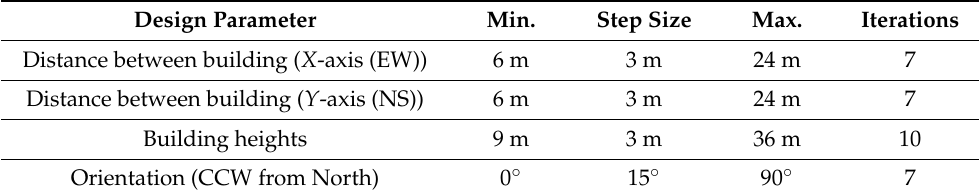
Table 1. Minimum, maximum and step size of each dynamic parameter simulated. Design Parameter Min. Step Size Max. Iterations Distance between building ( X -axis (EW)) 6 m 3 m 24 m 7 Distance between building ( Y -axis (NS)) 6 m 3 m 24 m 7 Building heights 9 m 3 m 36 m